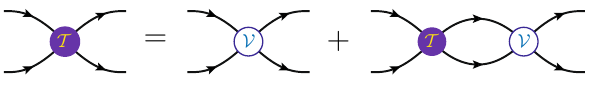
Fig. 2 The diagrams for the Bethe–Salpeter